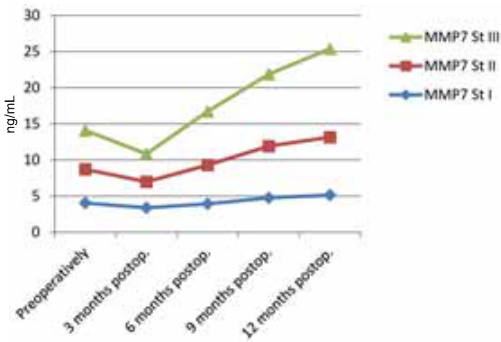
FIGURE 2. Mean MMP-7 (ng/mL) serum levels in terms of disease staging and defi ned points of